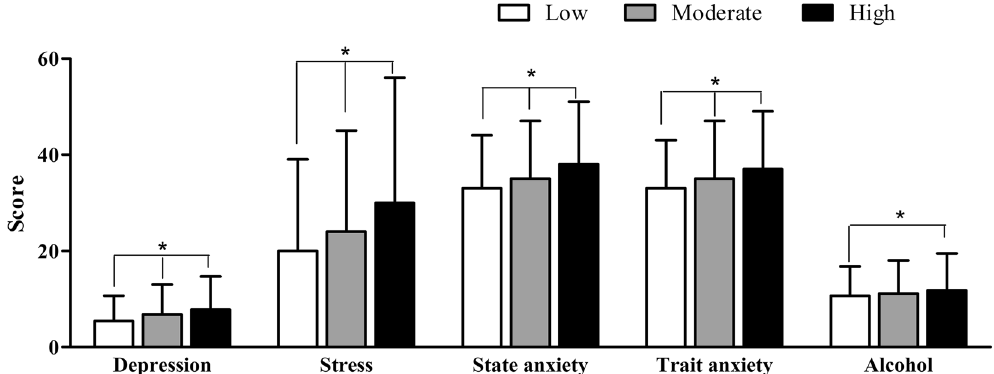
Figure 1. Mental health according to nicotine dependence. White bars, low nicotine dependence, Grey bars, moderate nicotine dependence, Black bars, high nicotine dependence, ┬ , standard deviation, *p < 0.05. The depression (p < 0.001), the stress score (p < 0.001), state (p < 0.001), trait (p < 0.001)—anxiety and alcohol score (p = 0.002) were higher with higher nicotine dependence. These results were also significant in the Scheffe’s post hoc test except alcohol dependence. Alcohol dependence showed a statistically significant difference only in the group with high nicotine dependence and the group with low nicotine dependence.